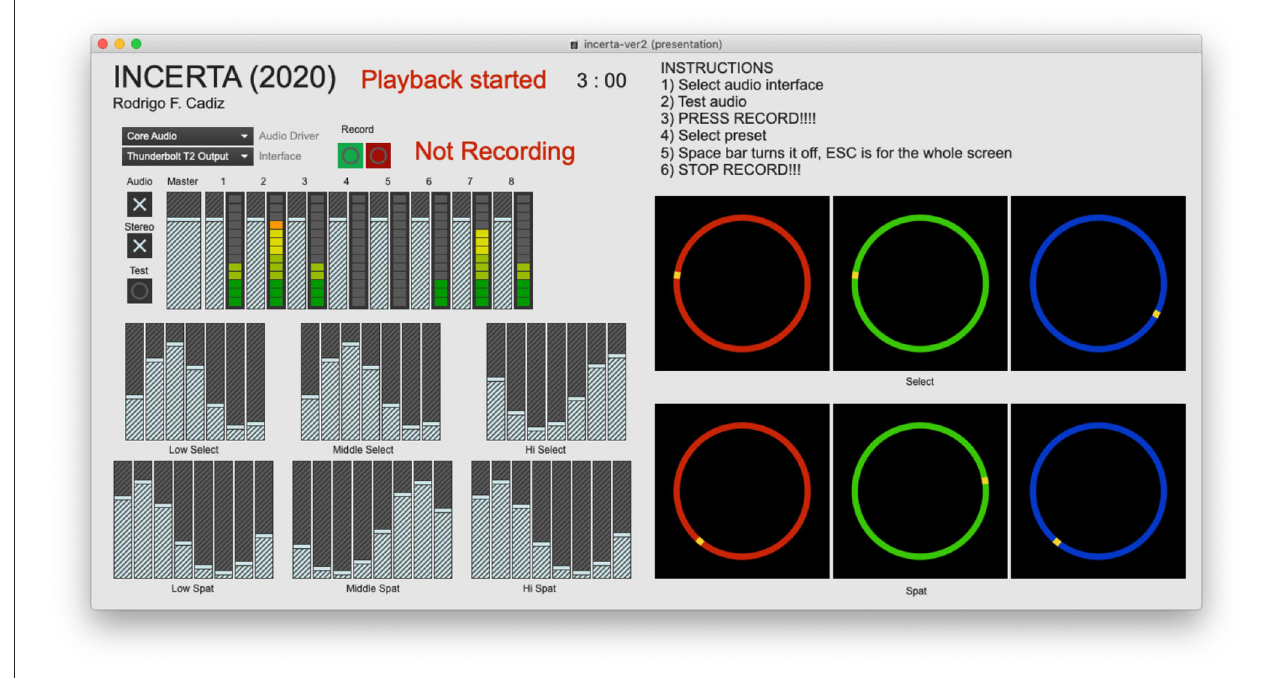
FIGURE 10 | Screenshot of the main interface of Incerta at time 3:00. The six Gaussian curves for the control of the sound material selection and spatialization can be seen at the bottom left. Circles on the right displays the rotation angle that is used to specify the mean value of each Gaussian curve.